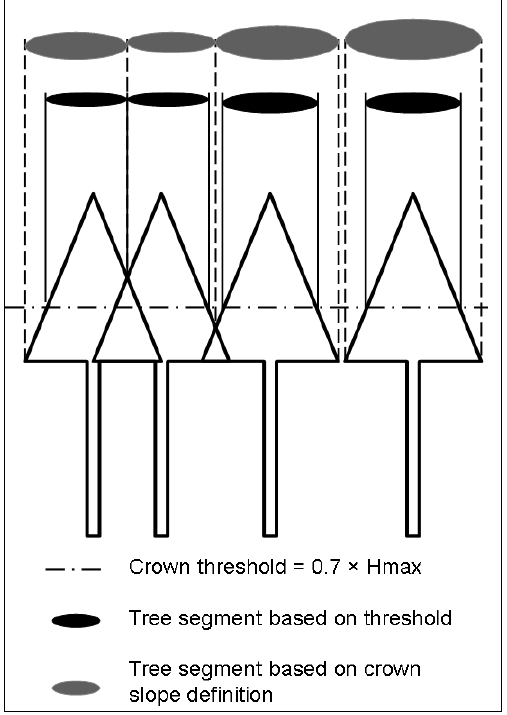
Figure 1. Tree crown delineation philosophy and its influence on crown segment